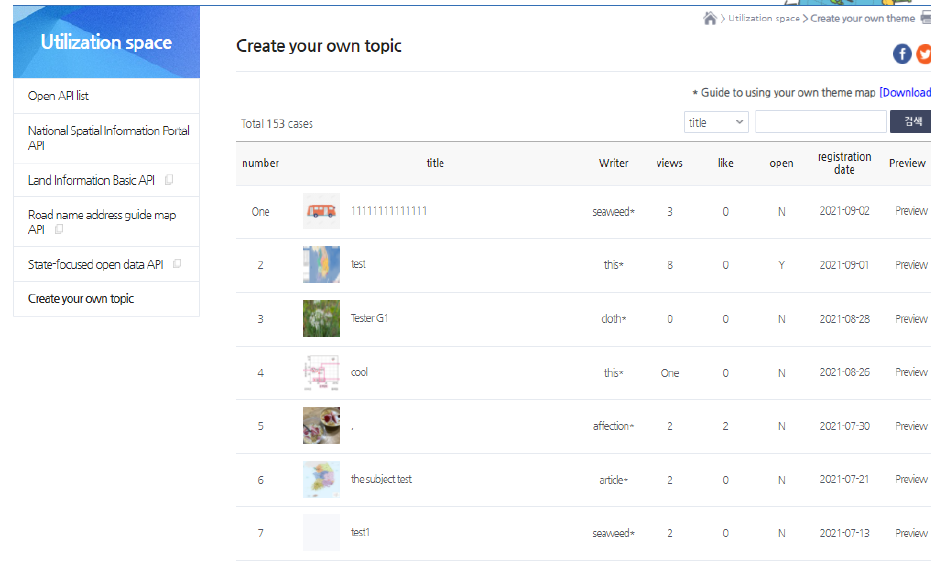
Figure 11. Register your ideas in ‘create your own topic’.